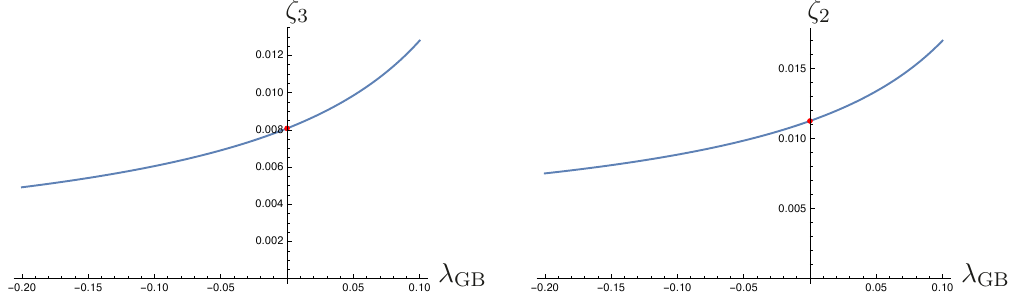
Figure 4 . Consistency test on extracting speed of the sound waves from the equation of state (2.18) and directly from the dispersion relation (3.6), see (3.9), for ∆ = 3 RG flow (left panel) and ∆ = 2 RG flow (right panel).